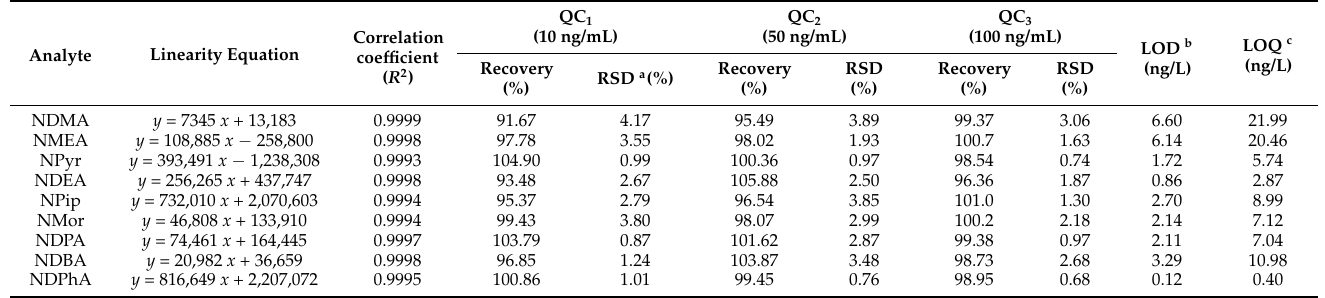
Table 4. Performance characteristics and linearity equation for nine N-nitrosamines determination in pure